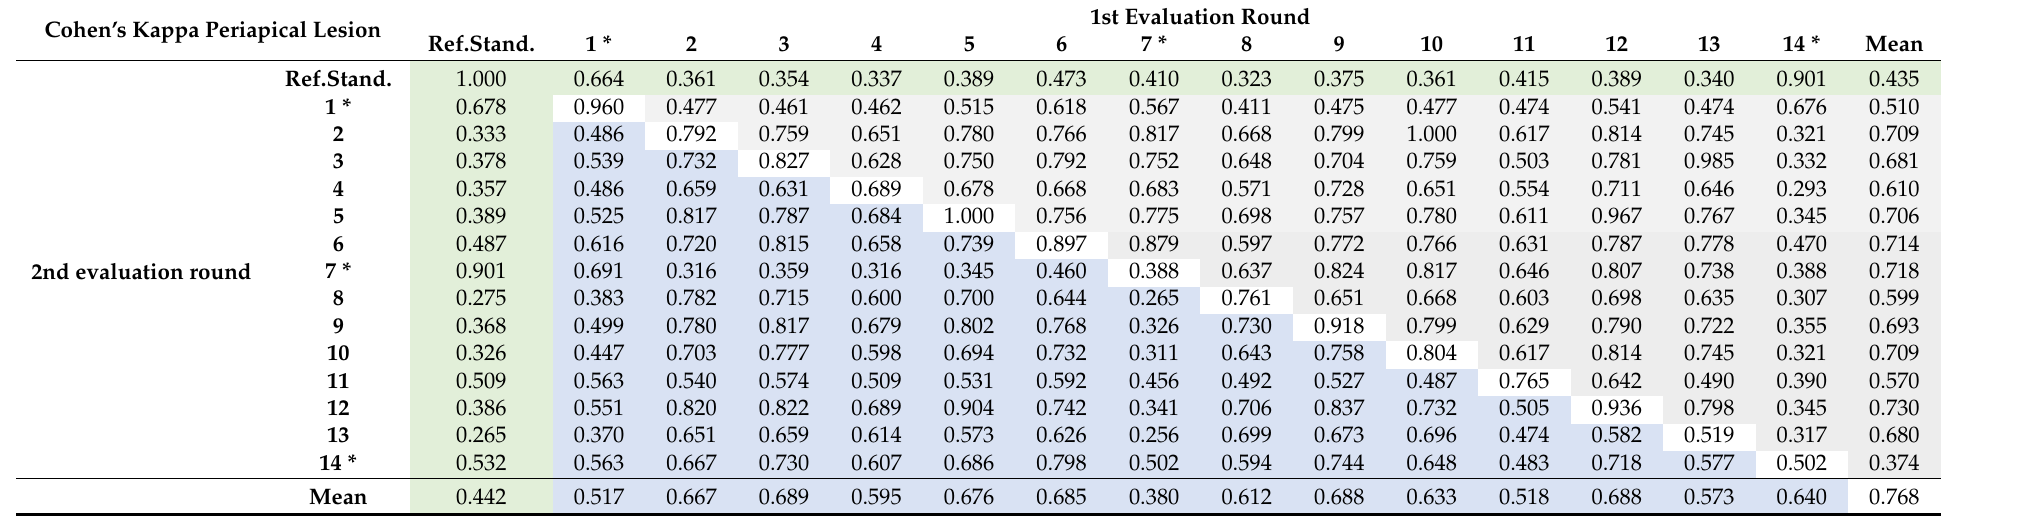
Table 2. Values of inter- and intra-rater reliability for the detection of periapical lesions which was calculated among all dentists (N = 14) and in relation to the reference standard (green coloured boxes). Grey coloured boxes illustrate inter-rater CK values of the first assessment and blue coloured boxes for the second assessment. White fields indicate intra-rater CK